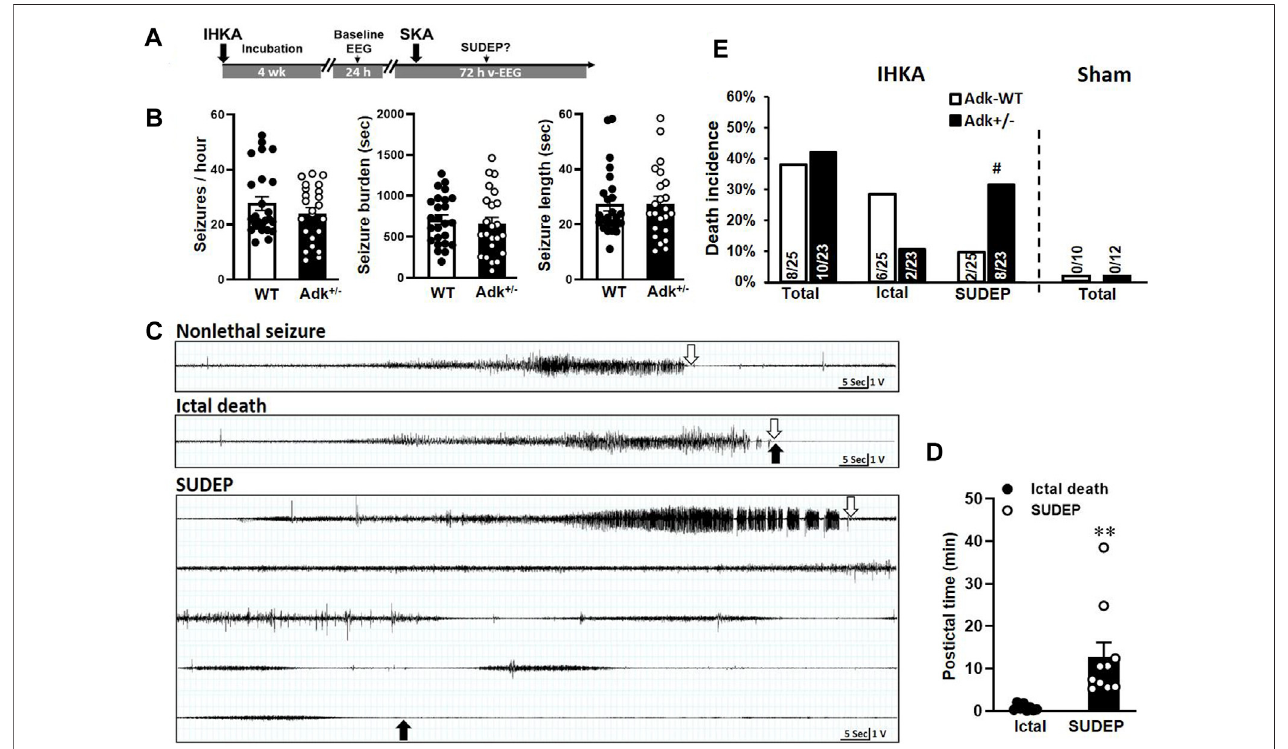
FIGURE 1 | Boosted kainic acid (KA) model of SUDEP. (A) Boosted KA administration paradigm that consists of an intrahippocampal KA (IHKA) injection followed by a single systemic KA (SKA) intraperitoneal (i.p.) injection. (B) Baseline EEG evaluation of Adk +/- mice and their WT littermates at 4 weeks after IHKA injection. (C) Representative EEG traces of non-lethal seizure (upper panel), ictal death (middle panel), and SUDEP event (lower panel). Open arrows indicate the stop points of seizures; solid arrows indicate the point of death occurrence. (D) The postictal period from the end of the seizure until the death occurred. (E) Rates of ictal death, SUDEP, and total mortality in mice received IHKA injection (IHKA) or vehicle control (Sham). Data are mean ± SEM. # p < 0.05 vs. SUDEP in Adk-WT, Fisher ’ s exact test, two-sided; ** p < 0.01 vs. ictal death, unpaired t